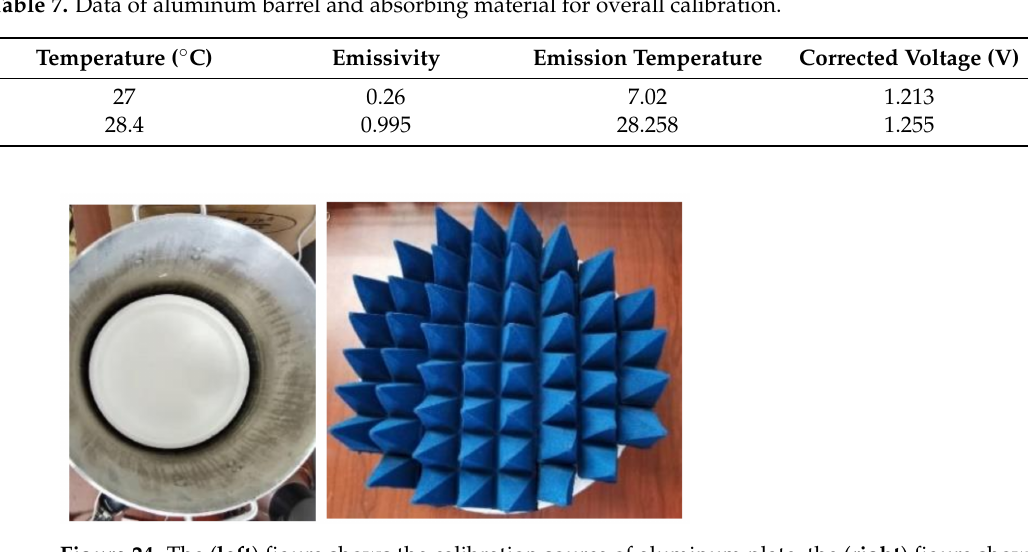
Figure 24. The ( left ) figure shows the calibration source of aluminum plate, the ( right ) figure shows the calibration source of absorbing material.